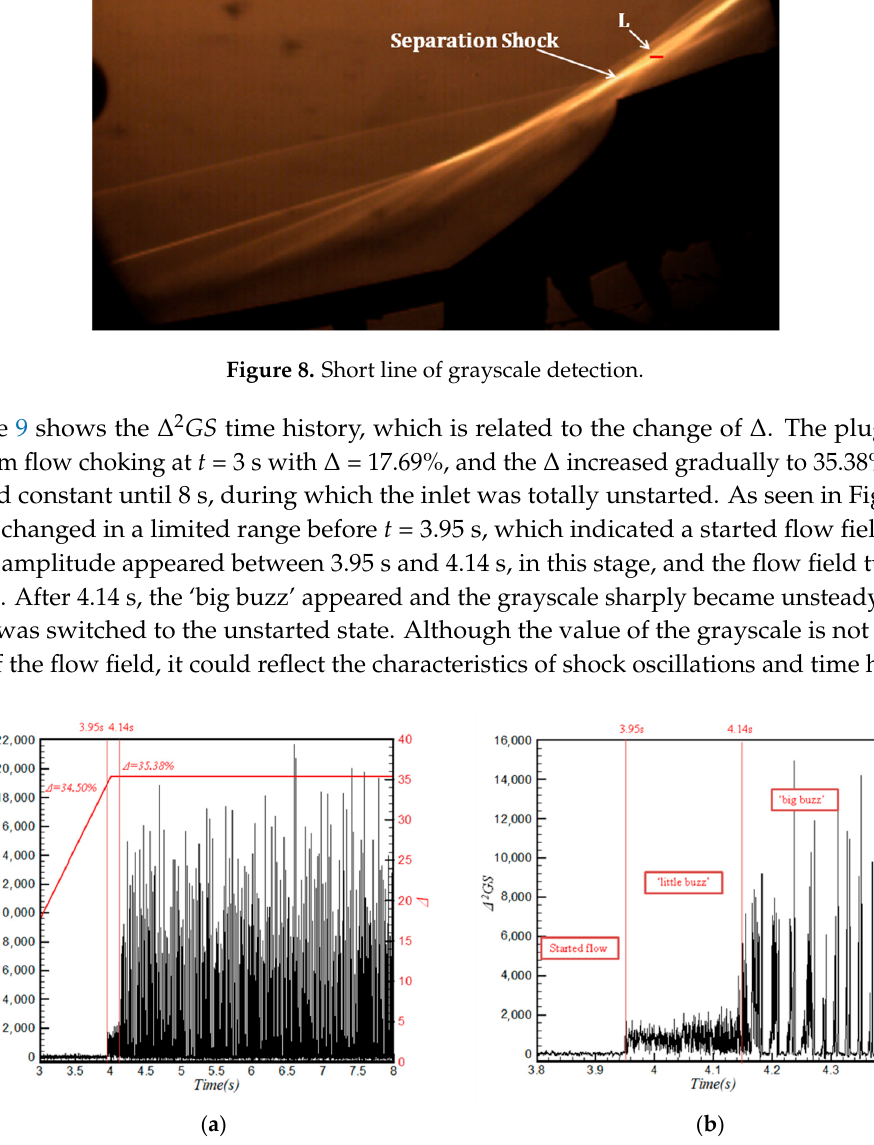
Figure 10. Time-frequency analysis of the grayscale of line L.